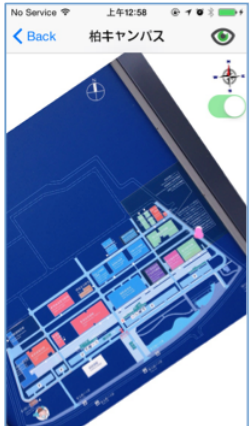
Figure 9. Auto-alignment of map image on related prototype of outdoor navigation